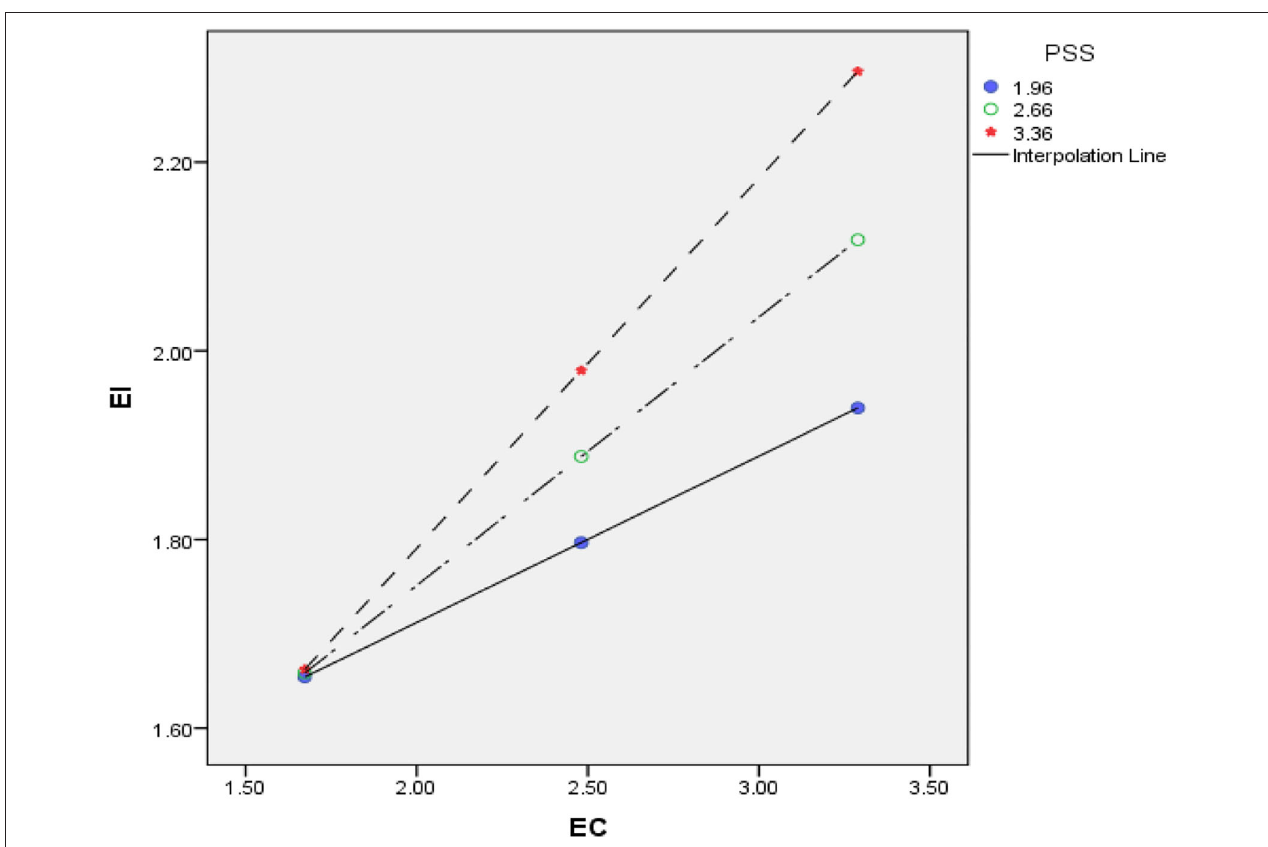
FIGURE 2 | Moderating role of PSS in the relation between EC and